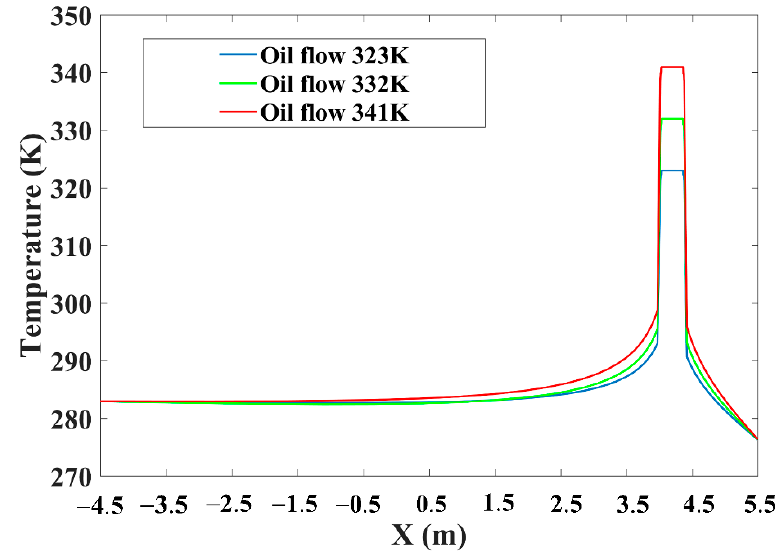
Figure 10. Temperature distribution along the centerline with different oil flow temperature.